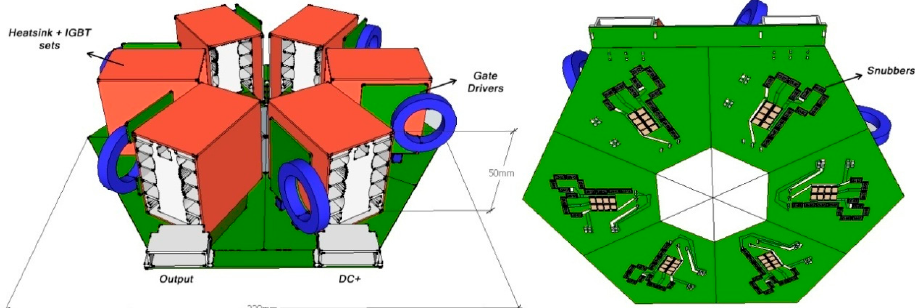
Figure 8. Upper and lower view of the integrated power sub-module with six serial IGBTs, gate driver circuits and snubbers.